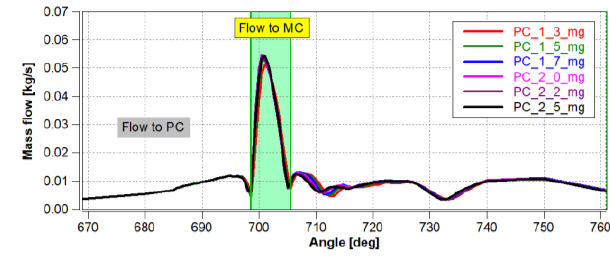
Fig. 8. Inter-chamber flows